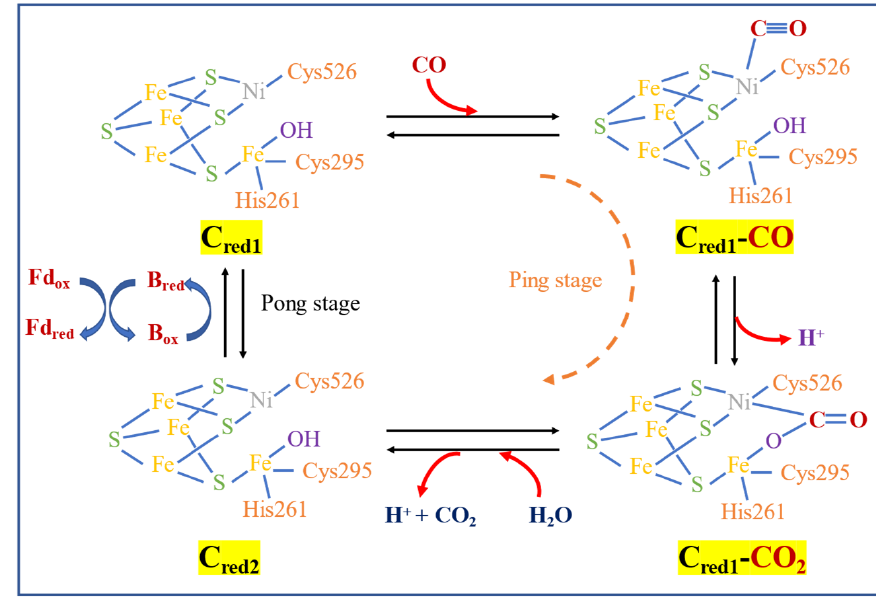
Figure 3. The ping pong reaction of CODH [113].